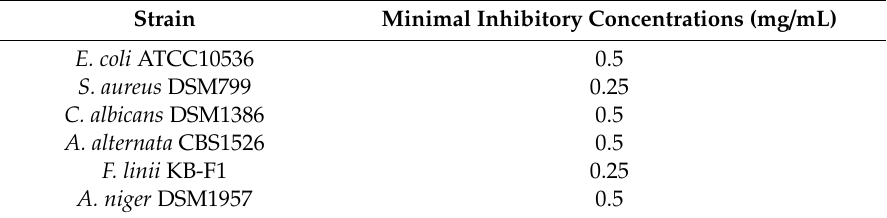
Minimal Inhibitory Concentrations (mg /